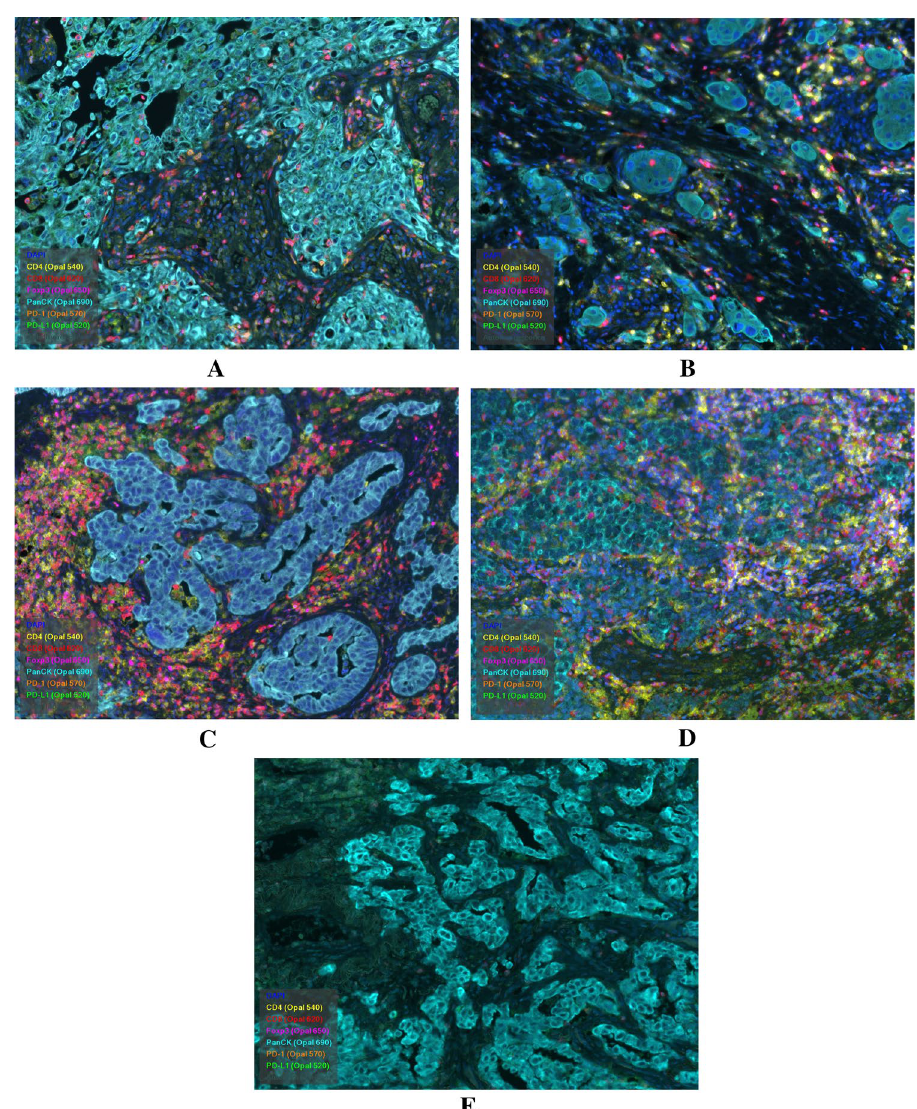
Fig. 1 CD8, Foxp3 and PD-1 lymphocytes were observed in the stroma and tumor ( A ). There was evidence of stromal infiltration of CD4 and CD8 lymphocytes ( B ). CD4, CD8, and Foxp3 lymphocytes highly infiltrated the stroma ( C ). Intratumoral infiltration of CD4, CD8, Foxp3, and PD-1 lymphocytes is highly recognized ( D ). There was no evidence of intratumoral or stromal infiltration of lympho- cytes ( E